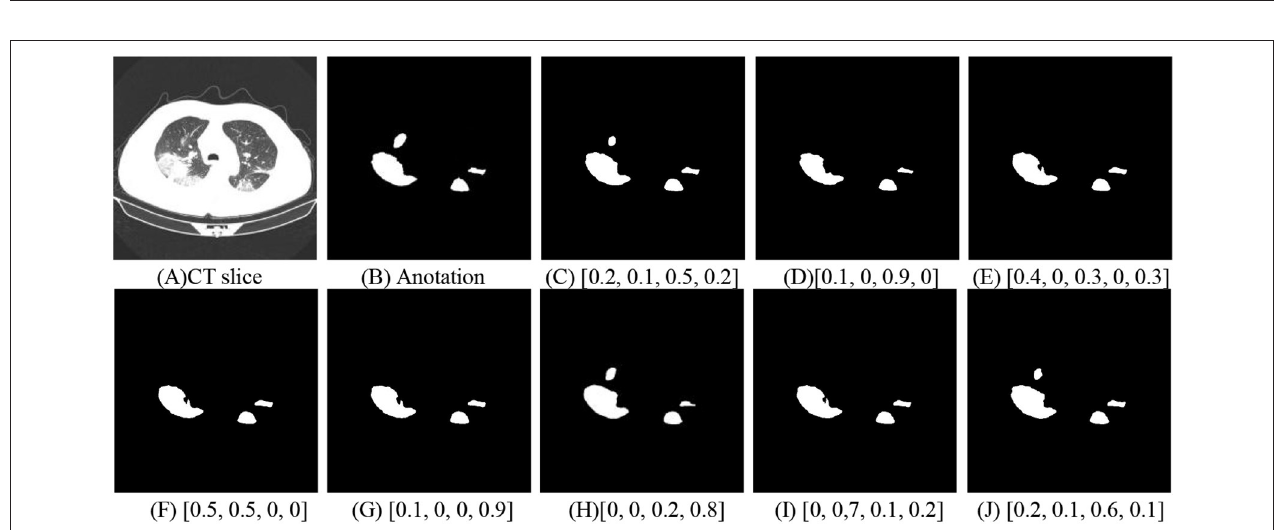
FIGURE 9 | Segmentation of COVID-19 lesions with different deep learning methods. (A) CT slice. (B) Anotation. (C) DeepLabV3+. (D) Unet. (E) PAN. (F) FPN. (G) Linknet. (H) MAnet. (I) PSPnet. (J) The proposed method.